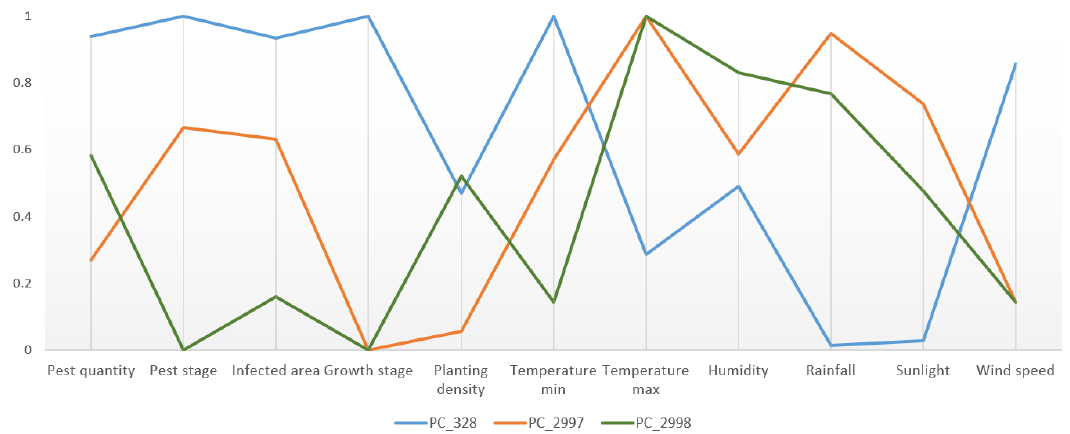
Figure 6. Data visualization of past cases 328, 2997 and 2998 after normalization.